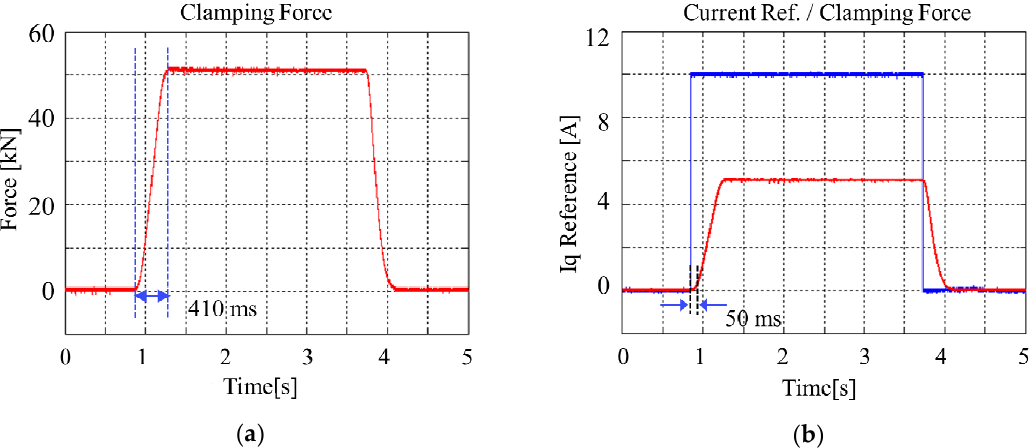
Figure 10. EMB experimental results: ( a ) clamping force; ( b ) response time of the clamping force.